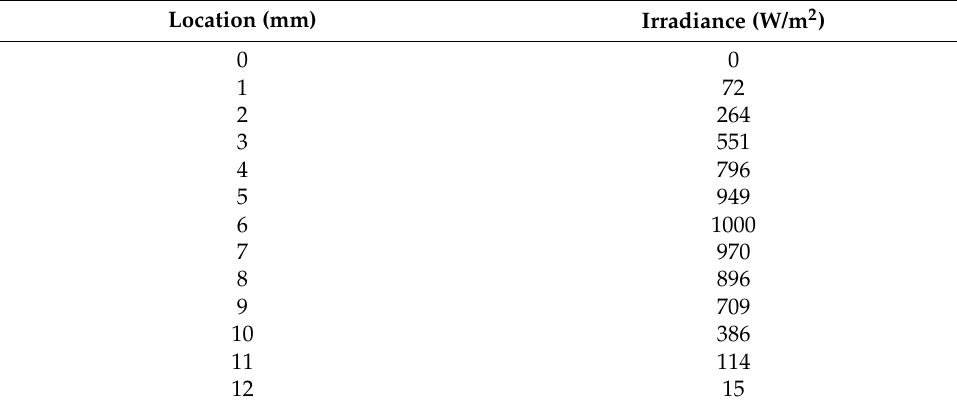
Figure 5. Photovoltaic (PV) receiver model under laser irradiation. Table 2. Irradiance distribution of the laser.